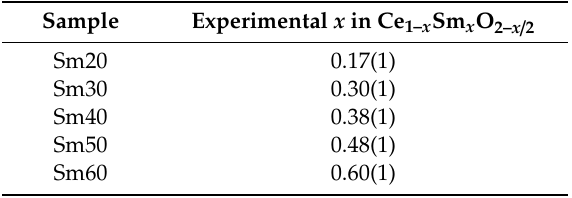
Table 1. Mean experimental x values as revealed by EDS